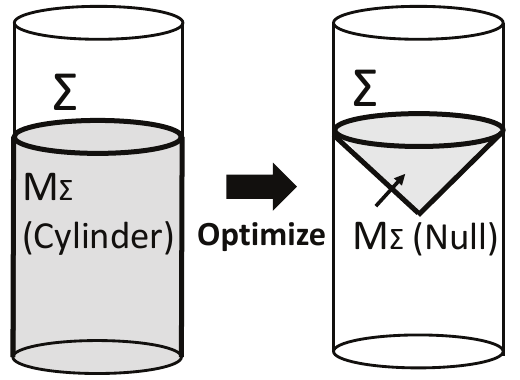
Figure 6 . The optimization of Lorentzian path-integral into null